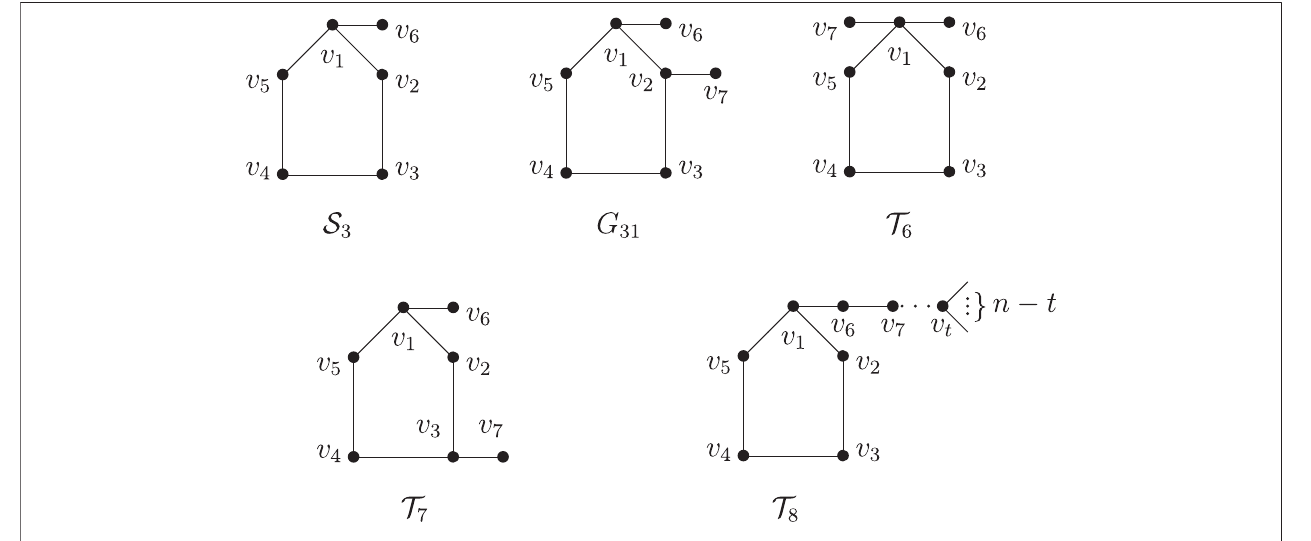
FIGURE 5 | Graphs S 3 , G 31 , T 6 , T 7 , and T 8